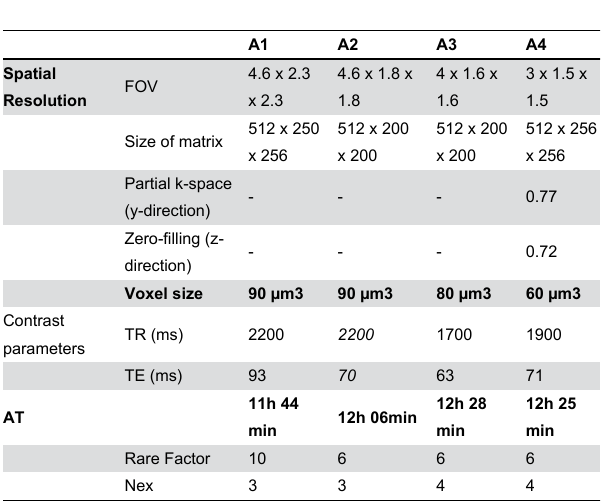
Table 1. MRI parameters tested during whole brain acquisition.